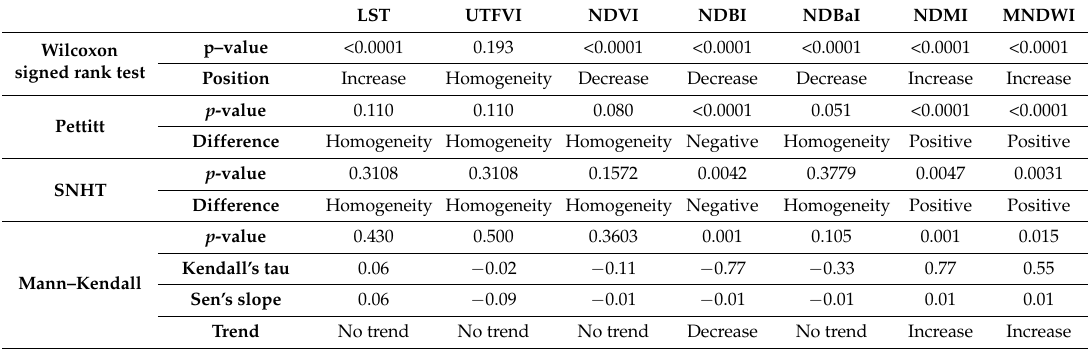
Table 7. Tests results for the Museum site on selected dates for median LST and spectral indices.